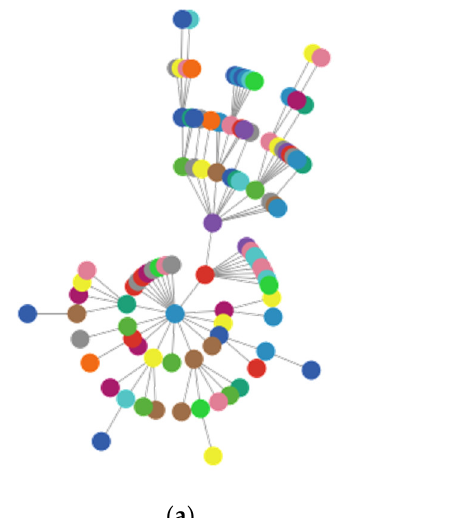
Then, each link is rewired with a probability of 0.05. Graphs obtained by simulation on complex networks are as follows (Figure 7a,b). The evolution of the MCC in each topology is observed.